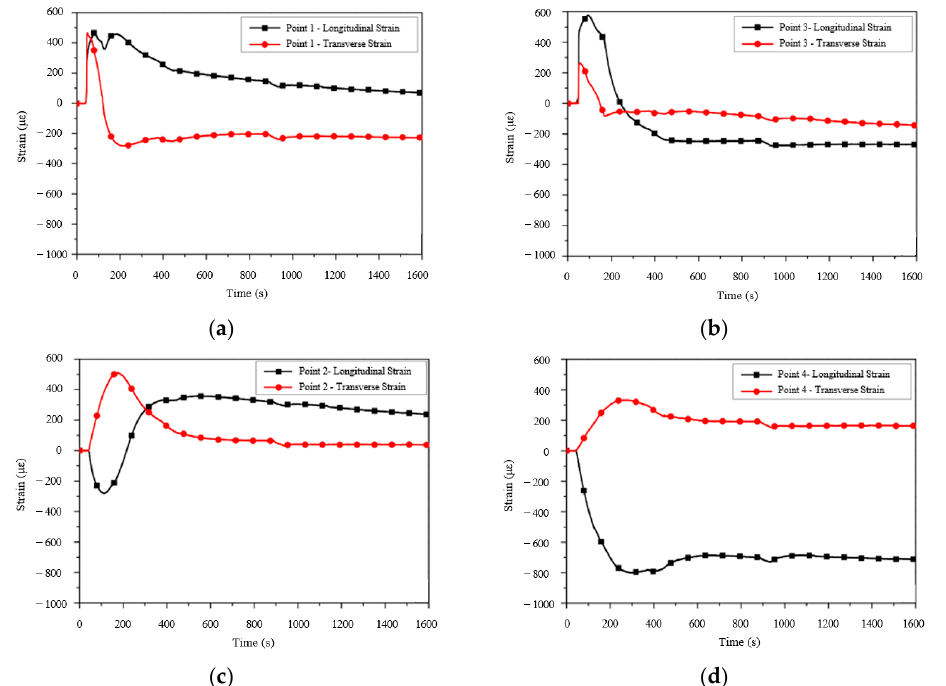
Figure 12. The strain curves in the longitudinal and transverse directions: ( a ) Point 1, ( b ) Point 2, ( c ) Point 3, and ( d ) Point 4.